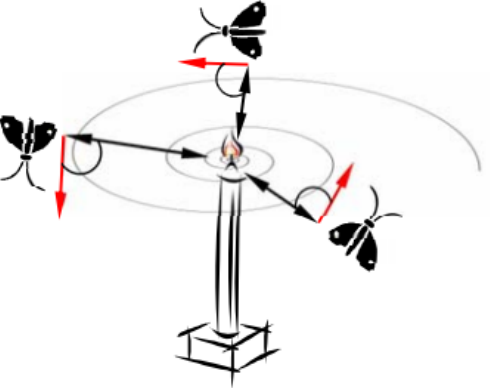
Figure 6. Spiral flight path of moths near artificial or natural point light sources [20].